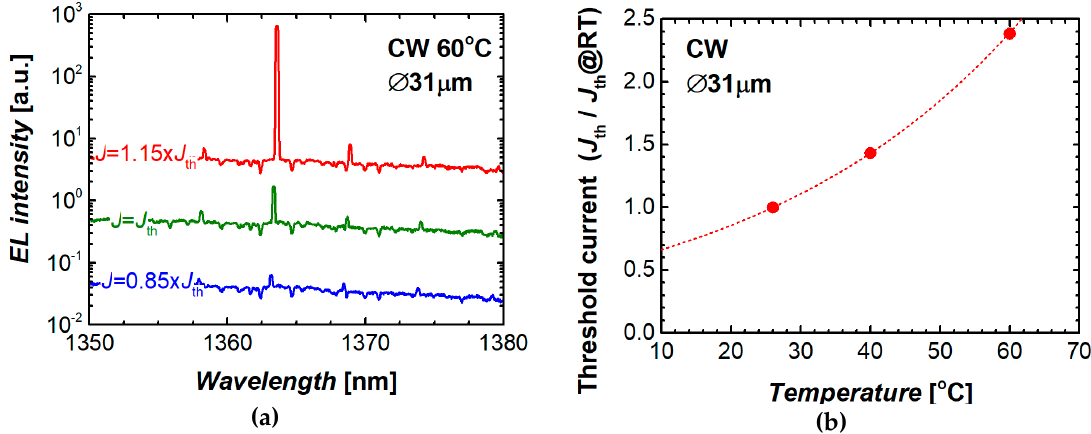
Figure 9. Series of emission spectra taken at 60 °C near lasing threshold ( a ) and temperature variation of threshold current ( b ). Dashed curve corresponds to characteristic temperature 39 K.